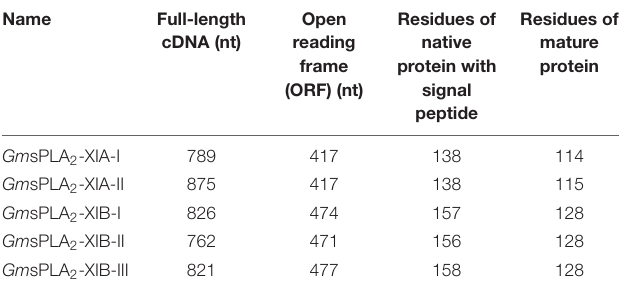
TABLE 3 | Sequence characteristics of the Gm sPLA 2 s a .